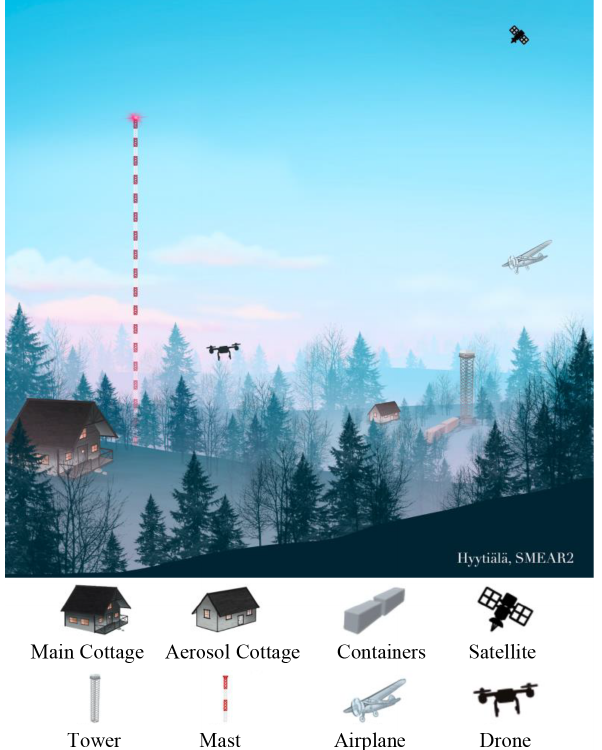
Figure 1. Overview of the SMEAR II station in Hyytiälä, Finland, used for staging the HyICE-2018 measurement campaign, with the available infrastructure and measurement platforms depicted.